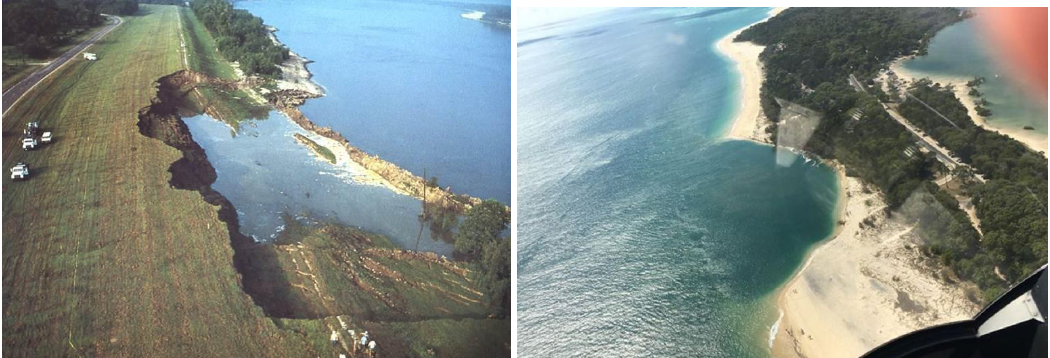
Figure 1. Damage to a river dike caused by a flow slide, from US Army Corps of Engineers, with the permission from Rogers, J.D. 2018 ( left ) [9]. A large collapse of beach at Inskip Point in Queensland due to a breaching event, with the permission from Rainbow Beach Helicopters Australia, 2019 ( right ) [10] . It was common to consider flow slides to be caused by soil liquefaction occurring in loose sand.